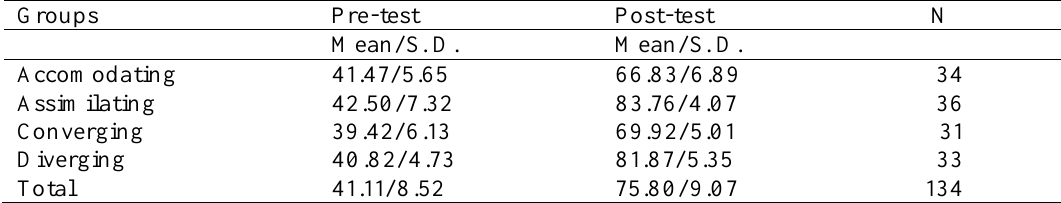
Results of Academic